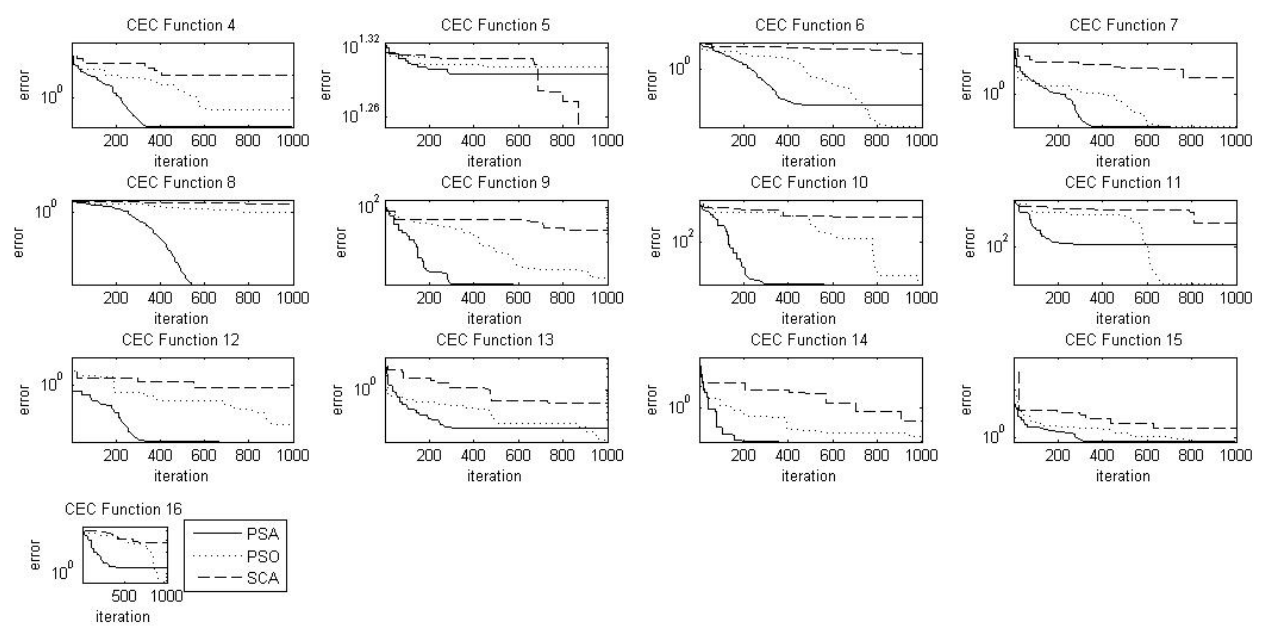
Figure 4. Convergence Curves.